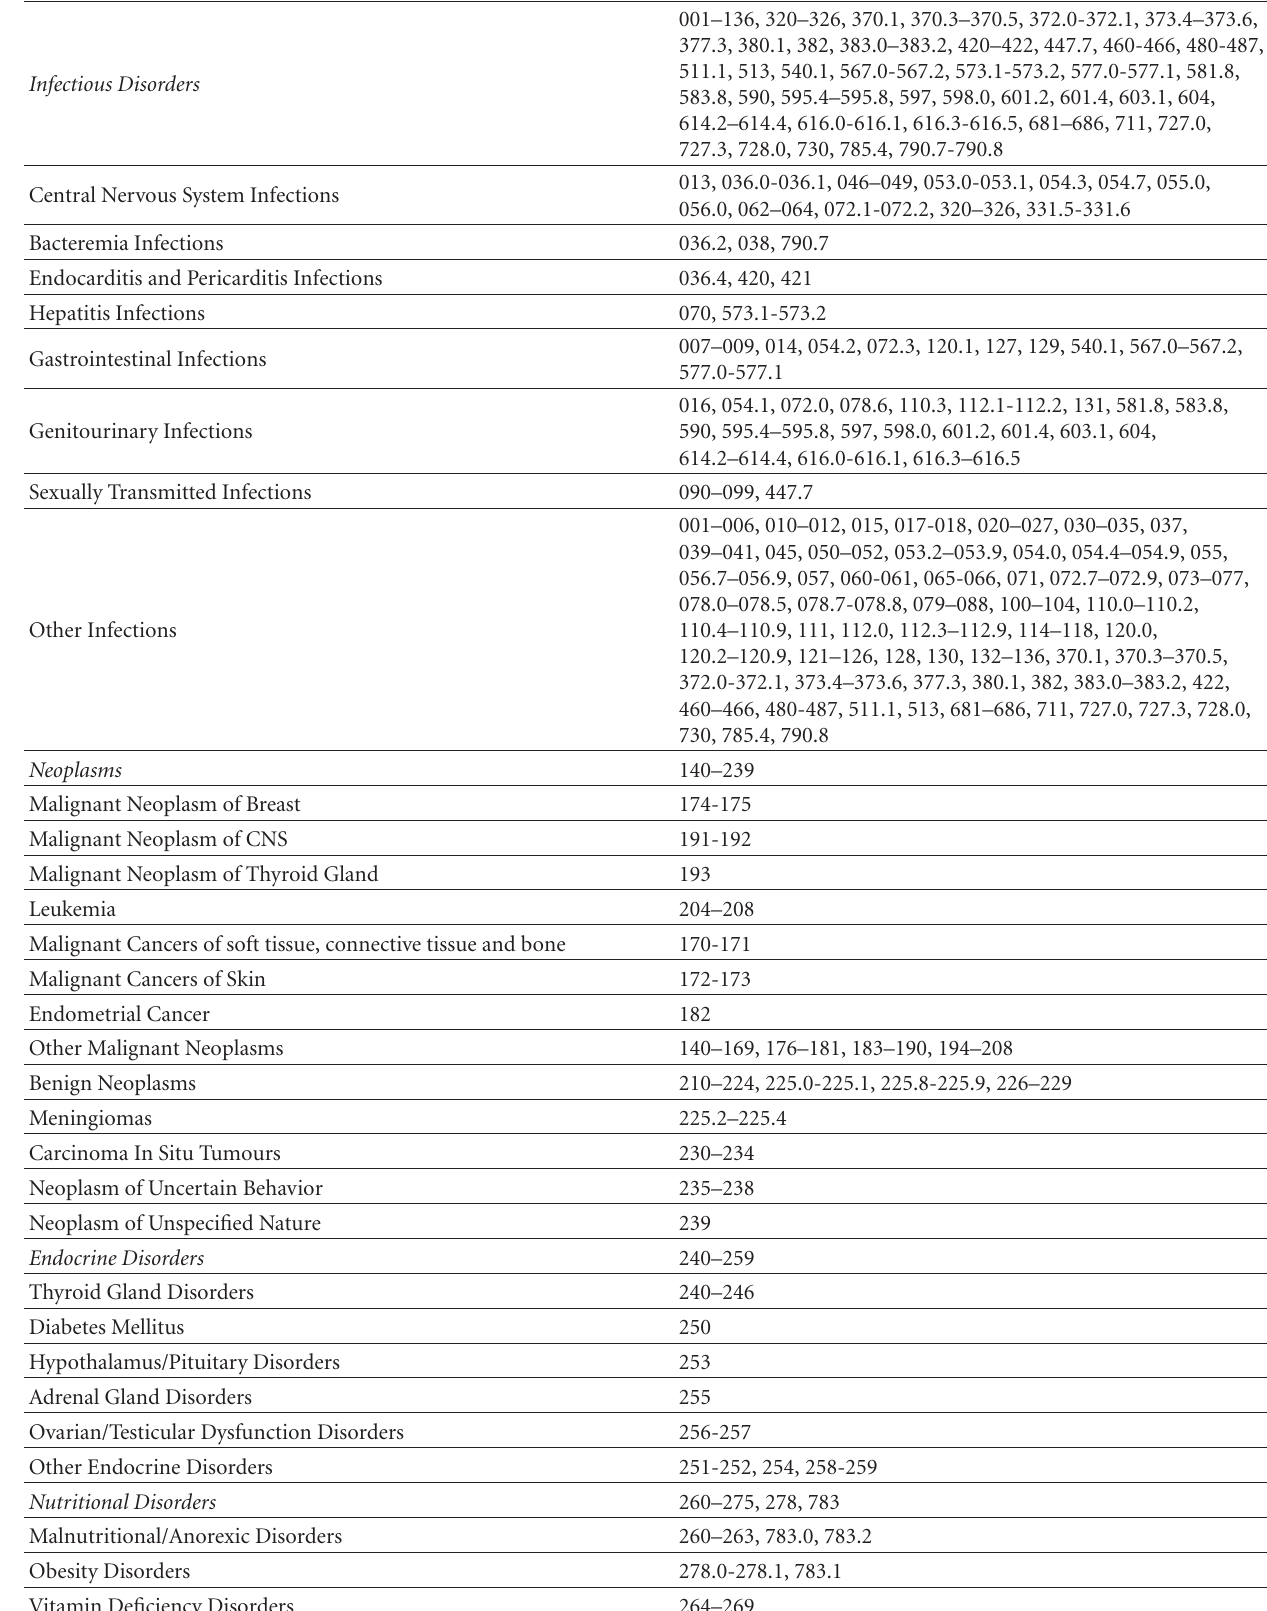
Table 2: Full categorization of ICD-9